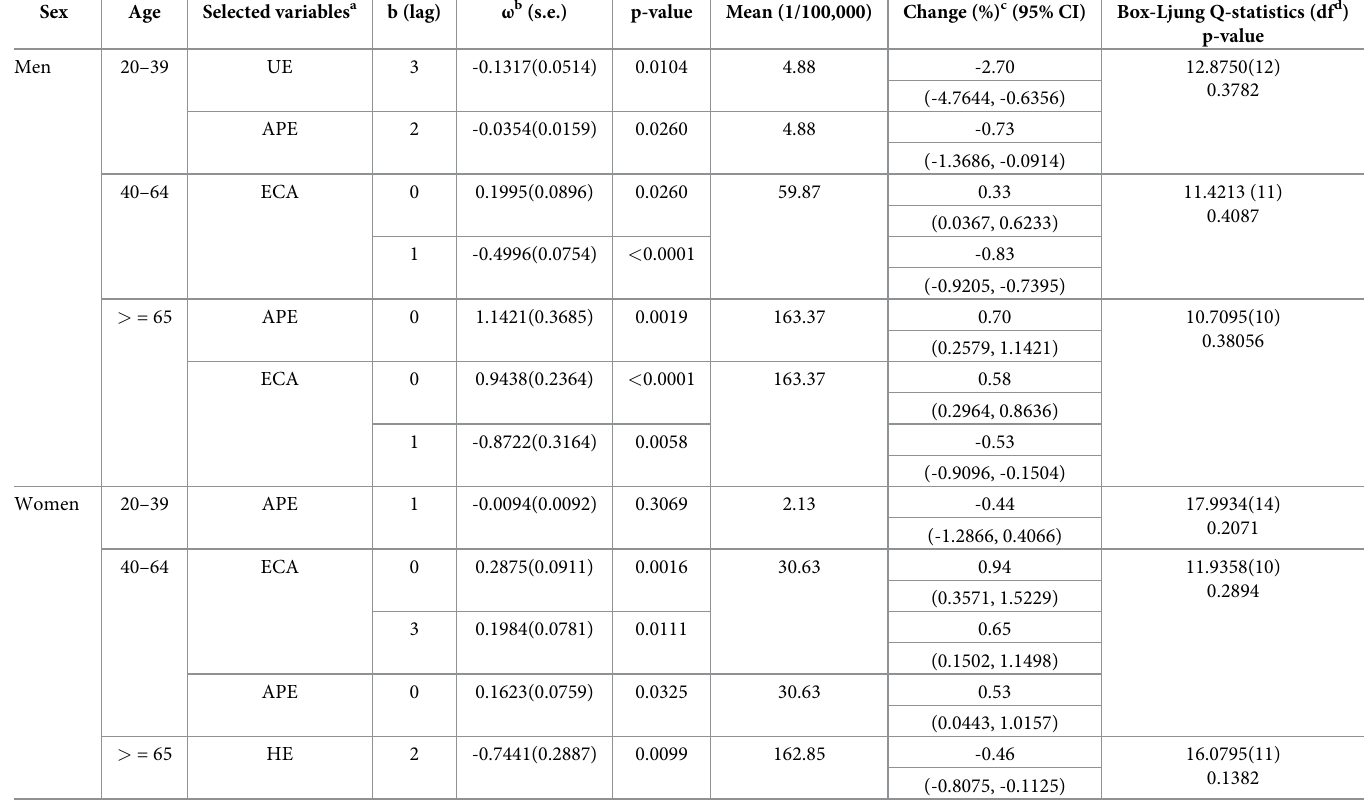
Table 4. Effects of socioeconomic factors on incidence rates of hospitalization due to stroke in Taiwan.